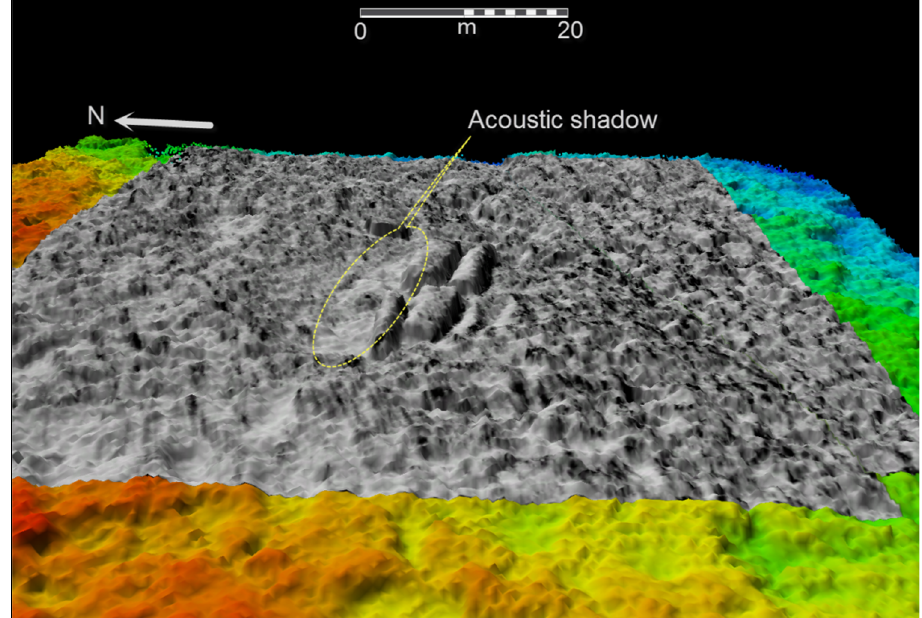
Figure 13. Backscatter intensity surface draped over bathymetry across wreck site 2. Relatively high backscatter is represented by relatively dark tones. The wrecked cargo is shown at the centre of the image as a group of very high backscatter orthogonal anomalies. Acoustic shadows are represented by white colour. A bathymetric pit can be observed principally north of the wrecked cargo up to 10 m away from it. The length scale refers to planar distance at the centre of the image.